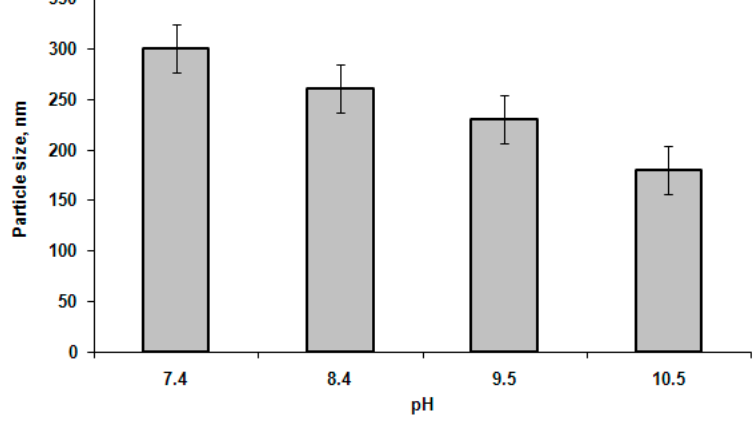
Figure 3. Dependence of particle size on pH (polymer sample GP1, concentration is 0.5 mg/mL).